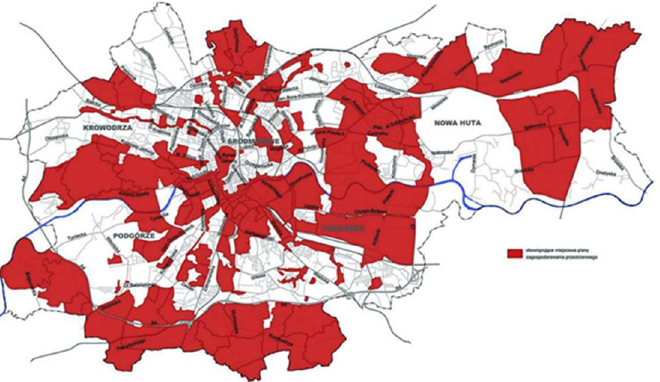
Figure 6. Map of binding sub-local zoning plans (red color) as of 2016. Source: Romańczyk K. [32] and Krakow City Council, http://planowanie.um.krakow.pl/bpp/plany_obow.htm (accessed on 21 July 2021).